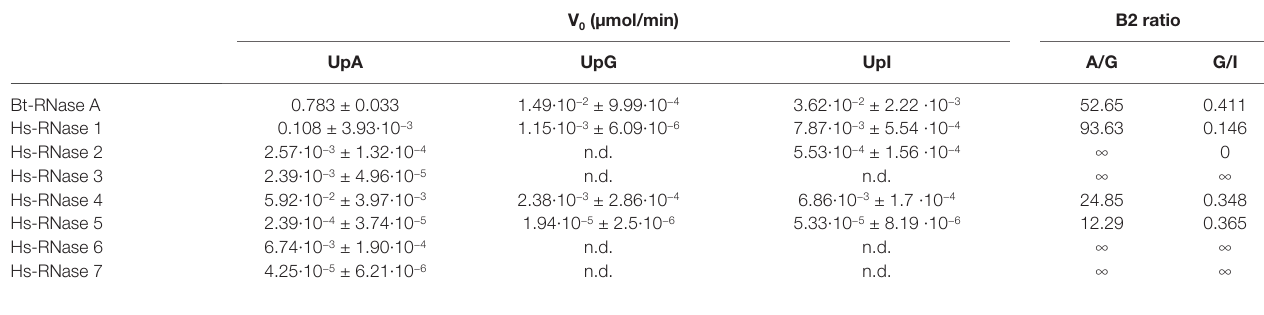
TABLE 1 | Kinetic activity of RNase A and the human RNases